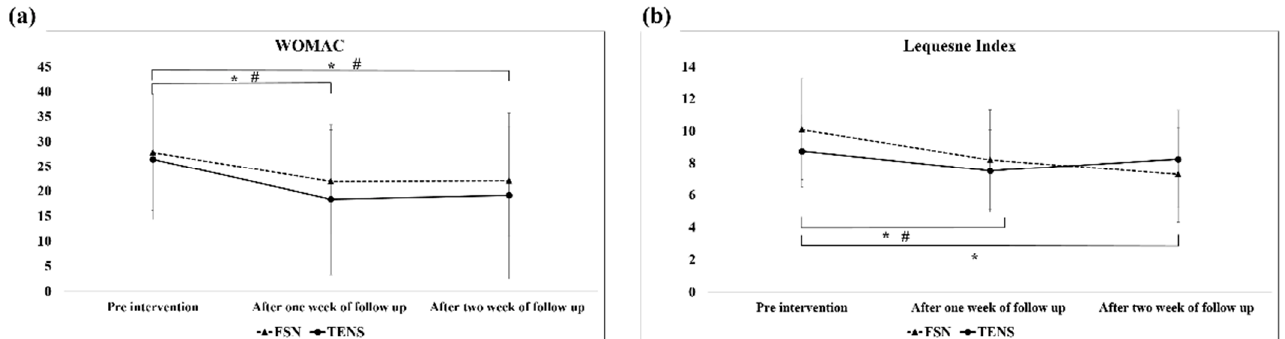
Data are expressed as the mean ± SD; * indicates a significant difference, analyzed by a paired t -test. Abbreviations: FNS, Fu’s subcutaneous needling; TENS, transcutaneous electrical nerve stimulation; WOMAC, Western Ontario and McMaster Universities.